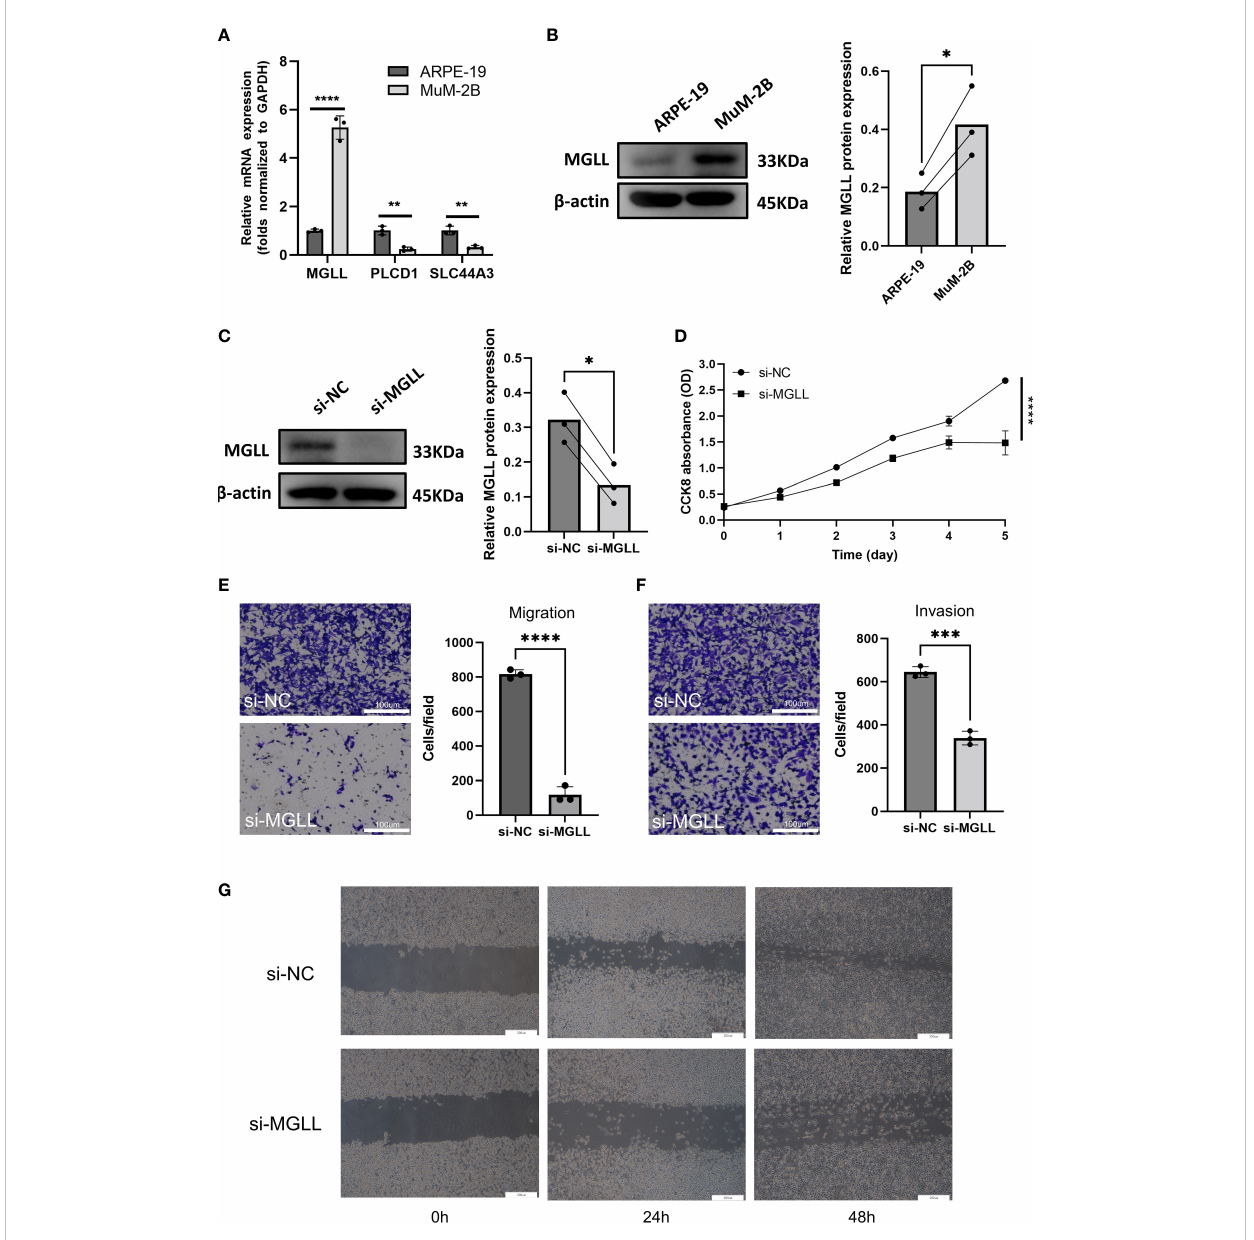
FIGURE 6 MGLL knockdown reduces UM cell migration, invasion, and activity in vitro . (A) Using qRT-PCR, the expression levels of ENPP2, MGLL, PLCD1, and SLC44A3 in ARPE-19 and MuM-2B cells were determined. ENPP2 mRNA expression was undetectable. Normalization of Ct values to GAPDH was performed. (Student ’ s t-test) (B) Using WB, MGLL levels in ARPE-19 and MuM-2B cells were examined, and relative protein expression was adjusted using -actin levels. (left: images indicative of three independent experiments; right: quantitative analysis, n = 3, paired Student ’ s t-test) (C) Western blotting revealed MGLL protein level in response to MGLL-siRNA treatment; relative protein expression levels were normalized based on -actin levels. (left: photos indicative of three independent experiments; right: quantitative analysis, n = 3, paired Student ’ s t-test) (D) Using the CCK-8 test, growth curves for MuM-2B cells treated with MGLL knockdown were determined. (Student ’ s t-test) (E) To determine the migration of MuM-2B cells, a Transwell test was carried out. (left: typical images from three independent experiments; right: quantitative analysis, n = 3, unpaired Student ’ s t- test, scale bar represents 100 m m) (F) A Transwell experiment was conducted to identify the invasion of MuM-2B cells following MGLL knockdown treatment. (left: typical images from three independent experiments; right: quantitative analysis, n = 3, unpaired Student ’ s t-test, scale bar